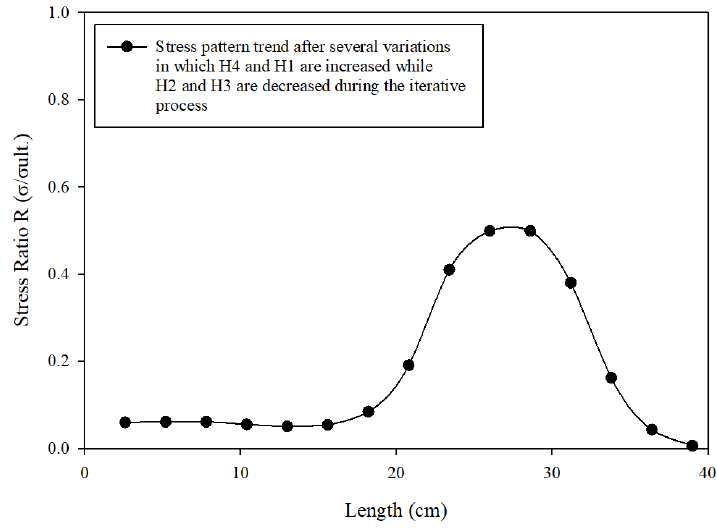
Figure 8. Stress profile pattern after several variations in the values of H1 – H4 during the iterative process.